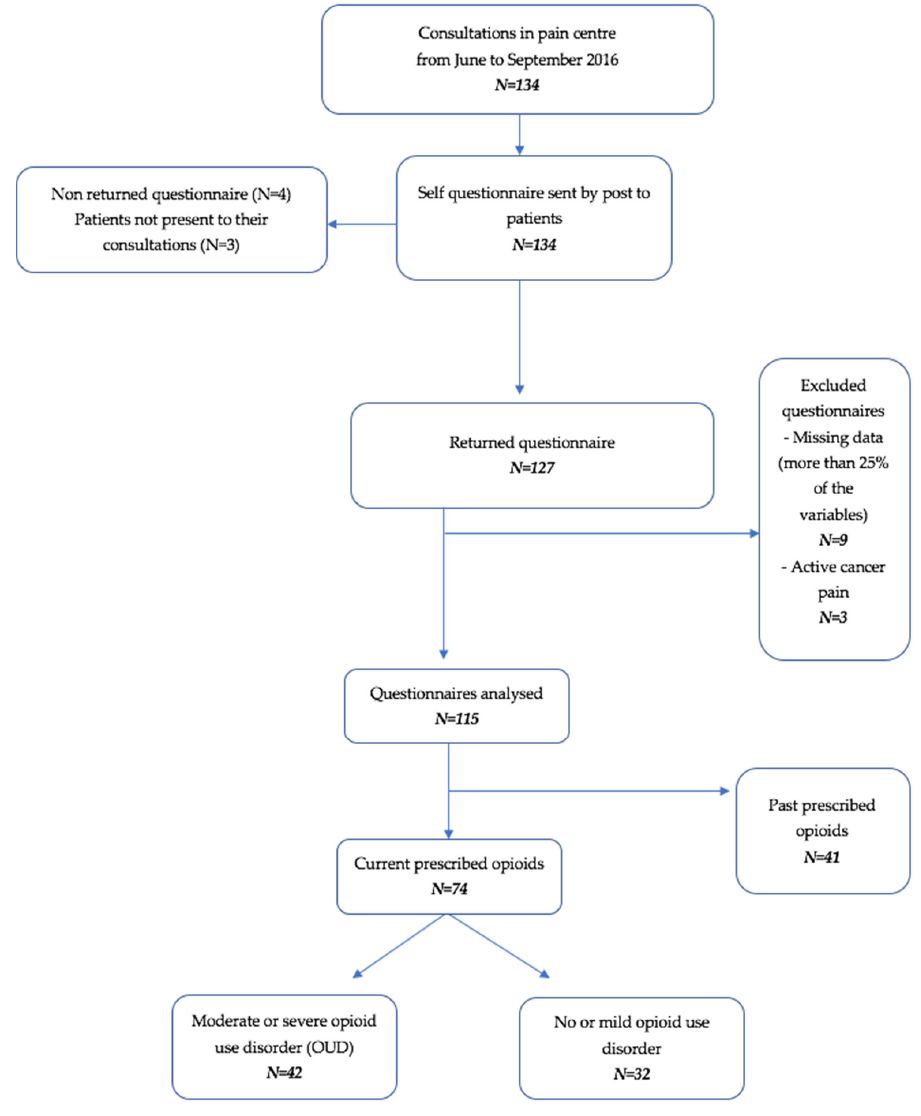
Figure 1. Flowchart of the study.